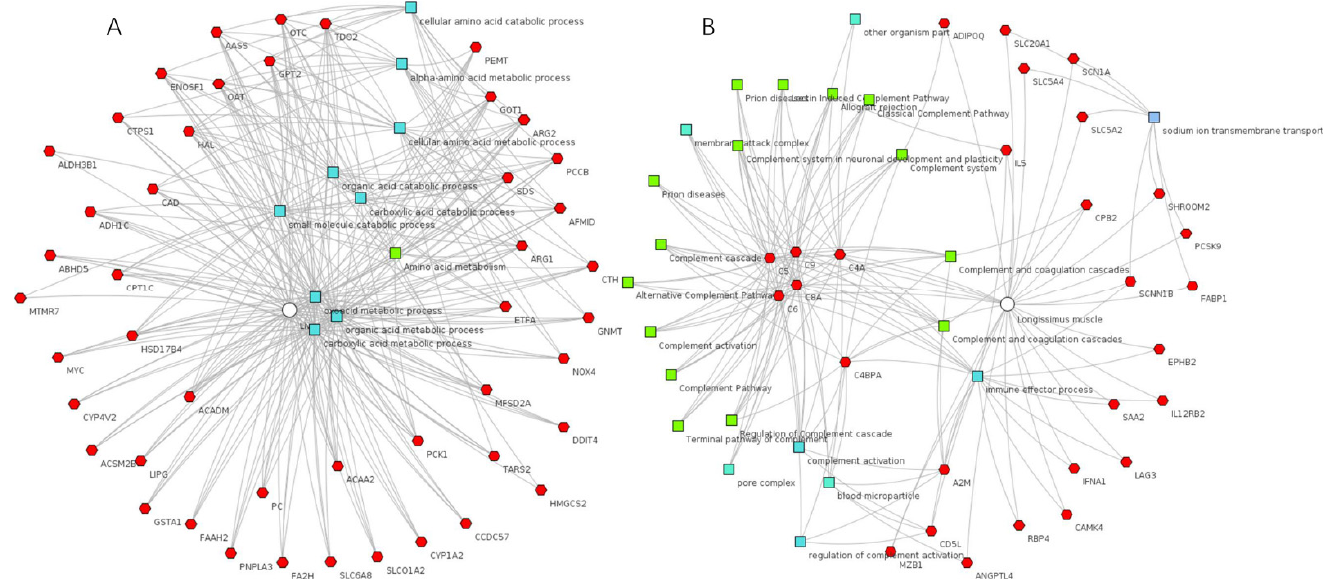
Figure 4. Relationships between differentially expressed genes, KEGG pathways, and GO terms of HL vs. LL ( A ) and HM vs. LM ( B ). Functional association analysis was performed using ToppCluster. Red hexagons: differentially expressed gene; green squares: pathway; blue squares: biological process; and gray squares: molecular